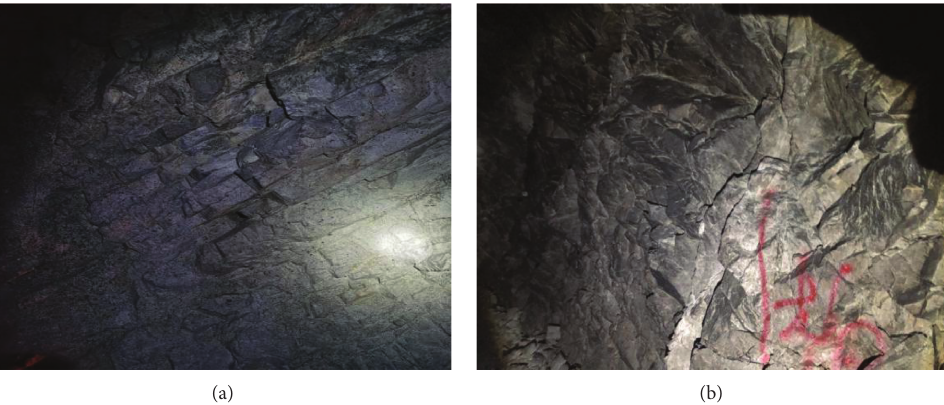
Figure 3: Roadways with developed joints and fractures. (a) − 1005m level, located at SSDF zone. (b) − 815 m level, located at JJF zone.